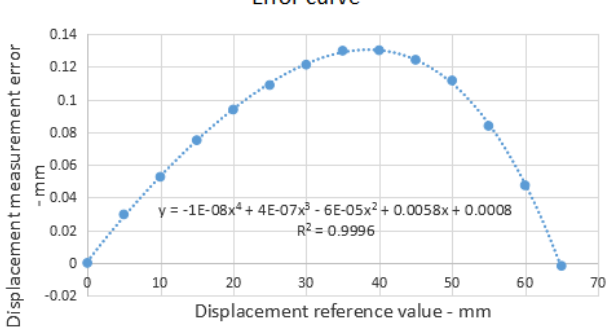
Figure 15. Displacement measurement error curve.